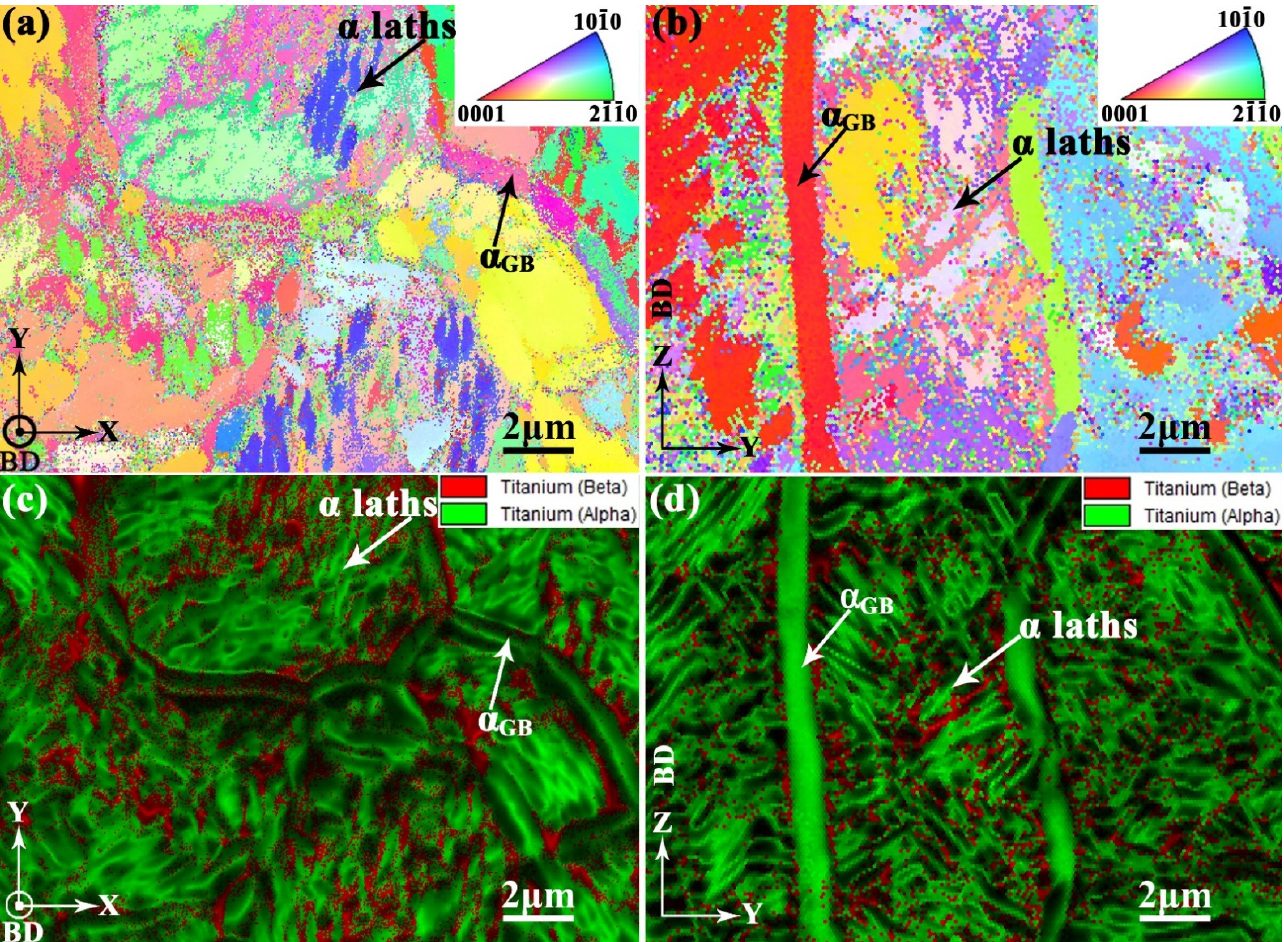
Figure 13. High magnification of EBSD pole figure (PF) maps of sample H-X at ( a ) XY- and ( b ) YZ- planes, respectively; the diffraction pattern qualities and phase maps at ( c ) XY- and ( d ) YZ-planes, respectively.